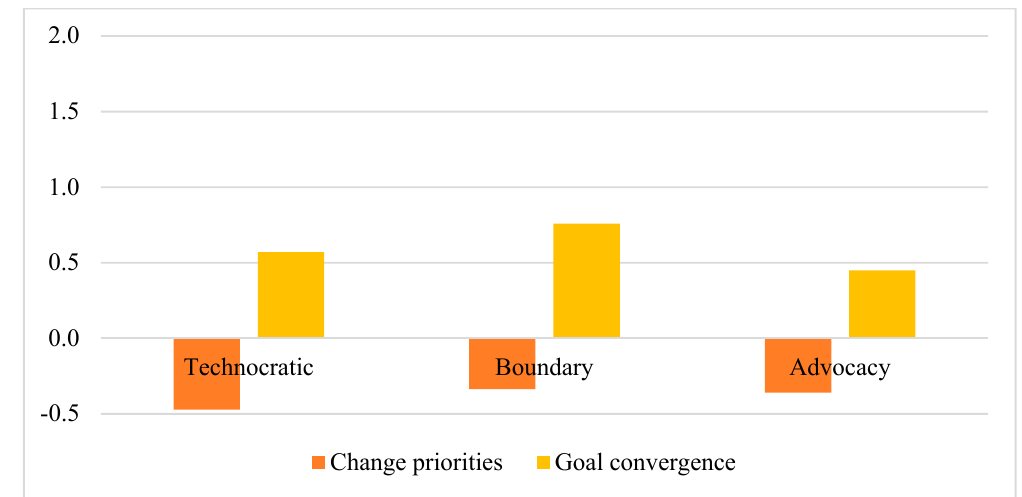
Figure 3. Comparing mean scores between ideal types, for both normative learning variables ( n = 18). High ≥ 1; medium = 0.5–1; low = 0–0.49; and none ≤ 0.